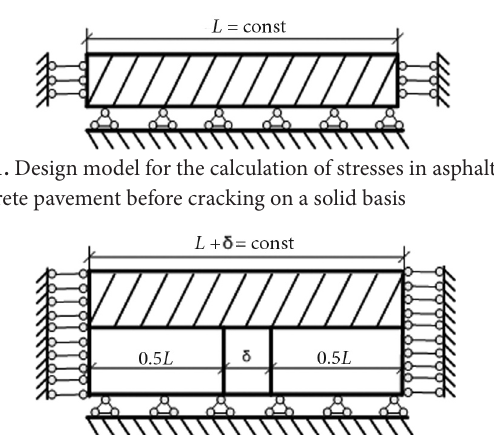
Fig. 2. Design models for the calculation of stresses in asphalt concrete pavement before cracking on a cracked basis